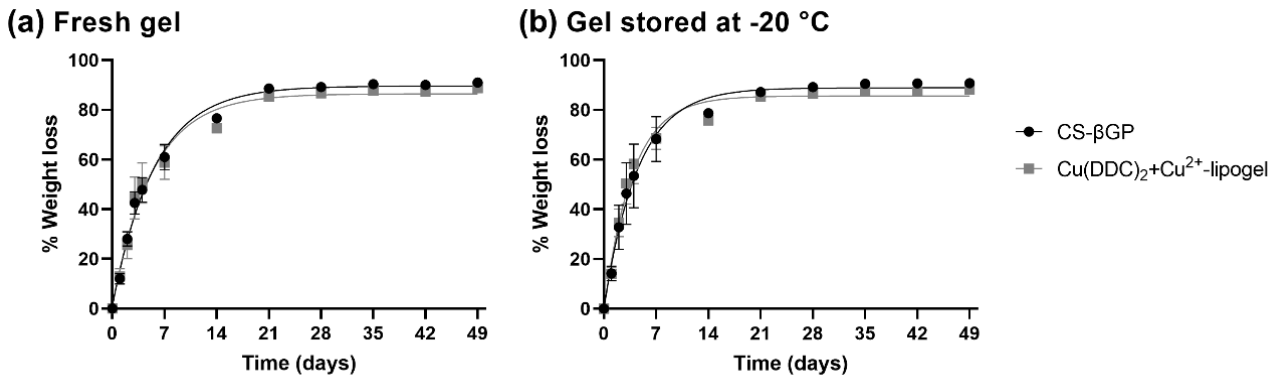
Figure 8. Non-linear fit of the percentage of accumulated weight loss over 49 days at 37 ◦ C of chitosan with β -glycerophosphate (CS- β GP) gel and Cu(DDC) 2 +Cu 2+ -lipogel. Weight loss of ( a ) freshly prepared gels or ( b ) gels based on CS- β GP stored at − 20 ◦ C. Data are expressed as mean ± standard deviation (n = 3). Table 3. Mean time until 50% of weight loss and rate constant based on non-linear fit of weight loss over 49 days at 37 ◦ C of chitosan with β -glycerophosphate (CS- β GP) gel or − 20 ◦ C stored CS- β GP gel, alone or as Cu(DDC) 2 +Cu 2+ -lipogel. Data are expressed as mean with 95% confidence interval (95% CI; n = 3).